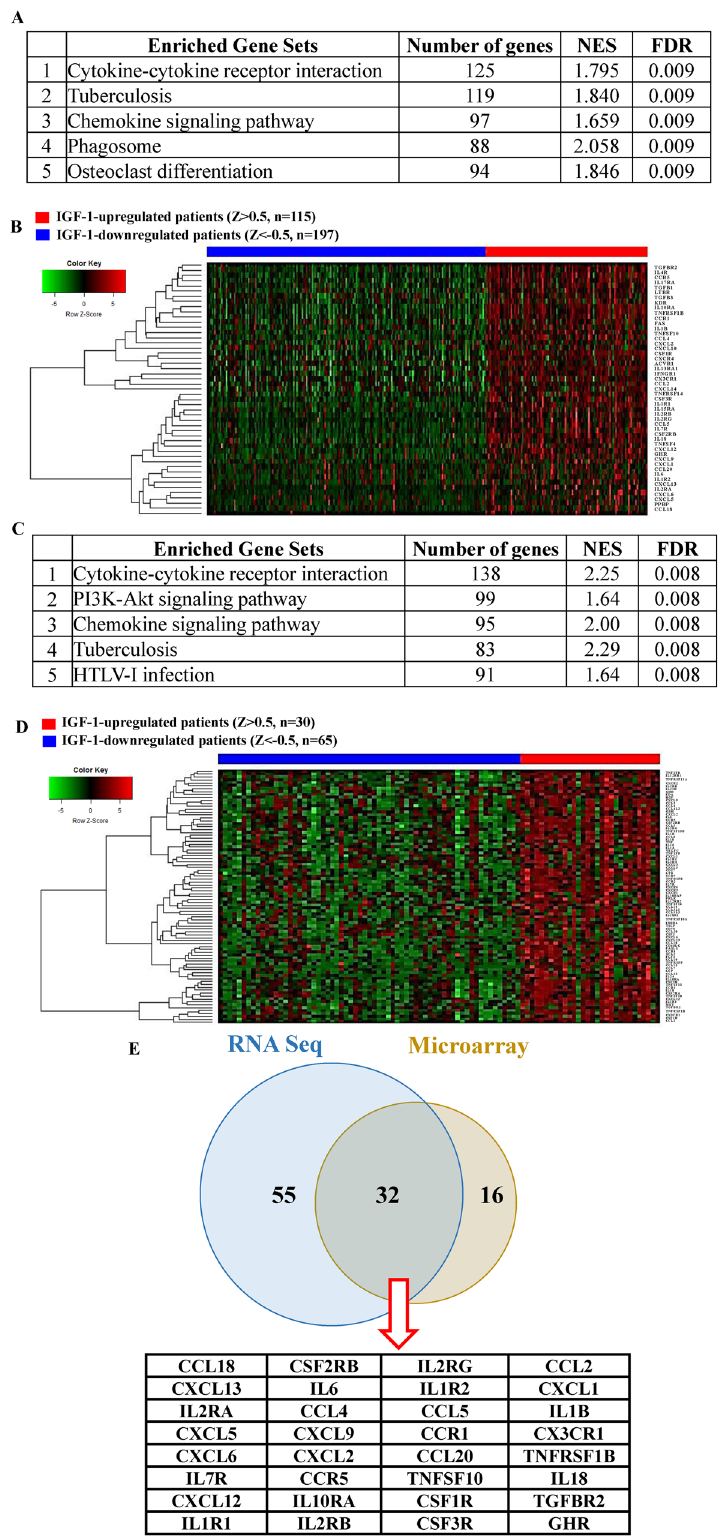
Figure 2. GSEA using microarray and RNA Seq data from TCGA for distinct molecular stratification of glioblastoma multiforme (GBM) patients with different insulin-like growth factor (IGF)-1 expression levels. Gene sets were based on biological processes from the Kyoto Encyclopedia of Genes and Genomes (KEGG). ( A ) The top five enriched pathways associated with the IGF-1 expression status in microarray data. The 5997 differentially expressed genes (DEGs) obtained from TCGA GBM microarray ( n = 528) with IGF-1 Z scores of > 0.5 (IGF1-upregulated, n = 115) or <− 0.5 (IGF1-downregulated, n = 197) and a false discovery rate